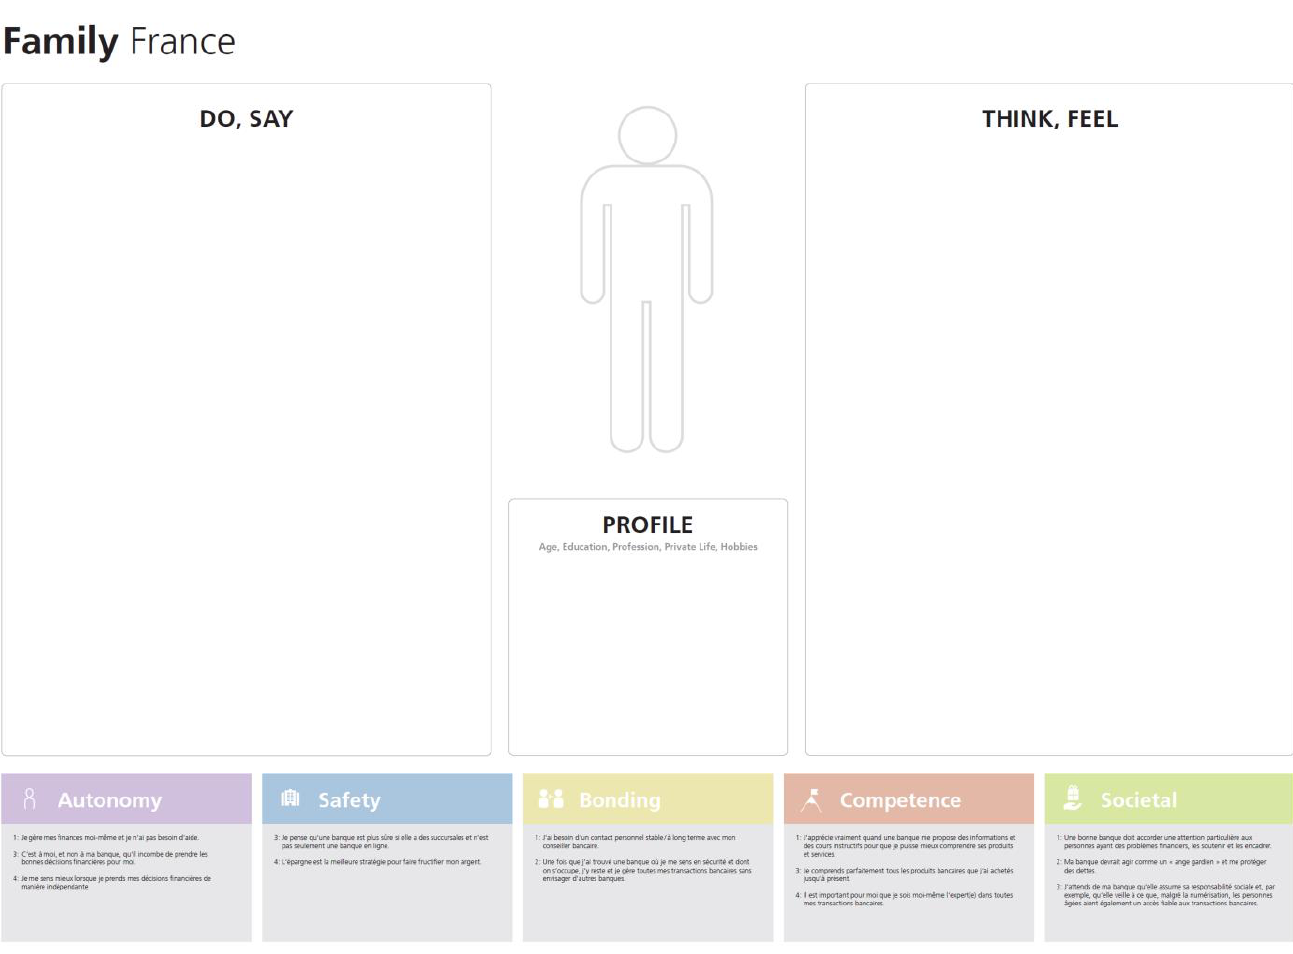
Figure 6. Needs Empathy Map (Phase II: Empathize).